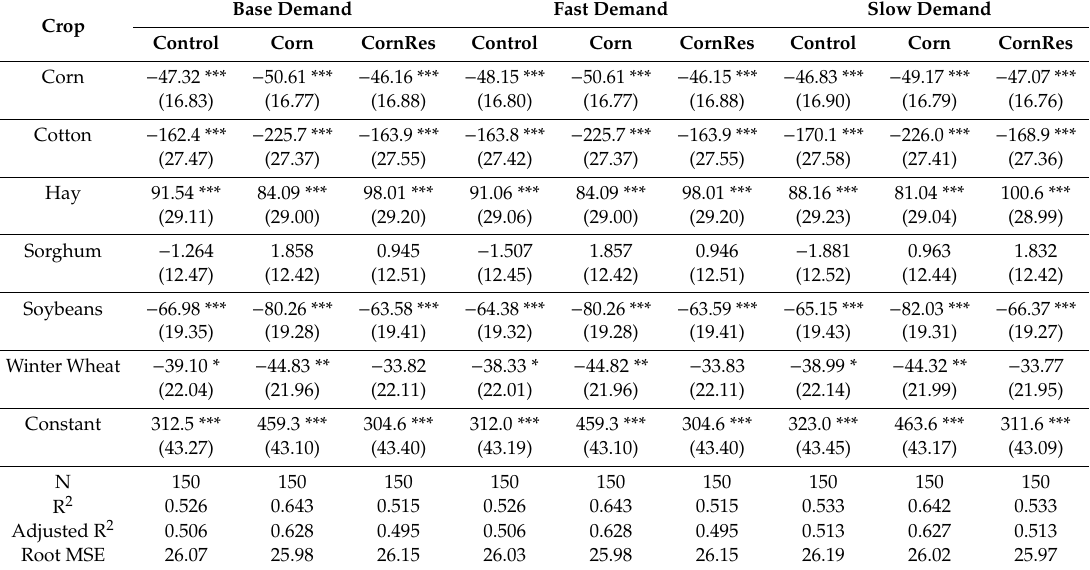
Table 10. GHG emissions regression